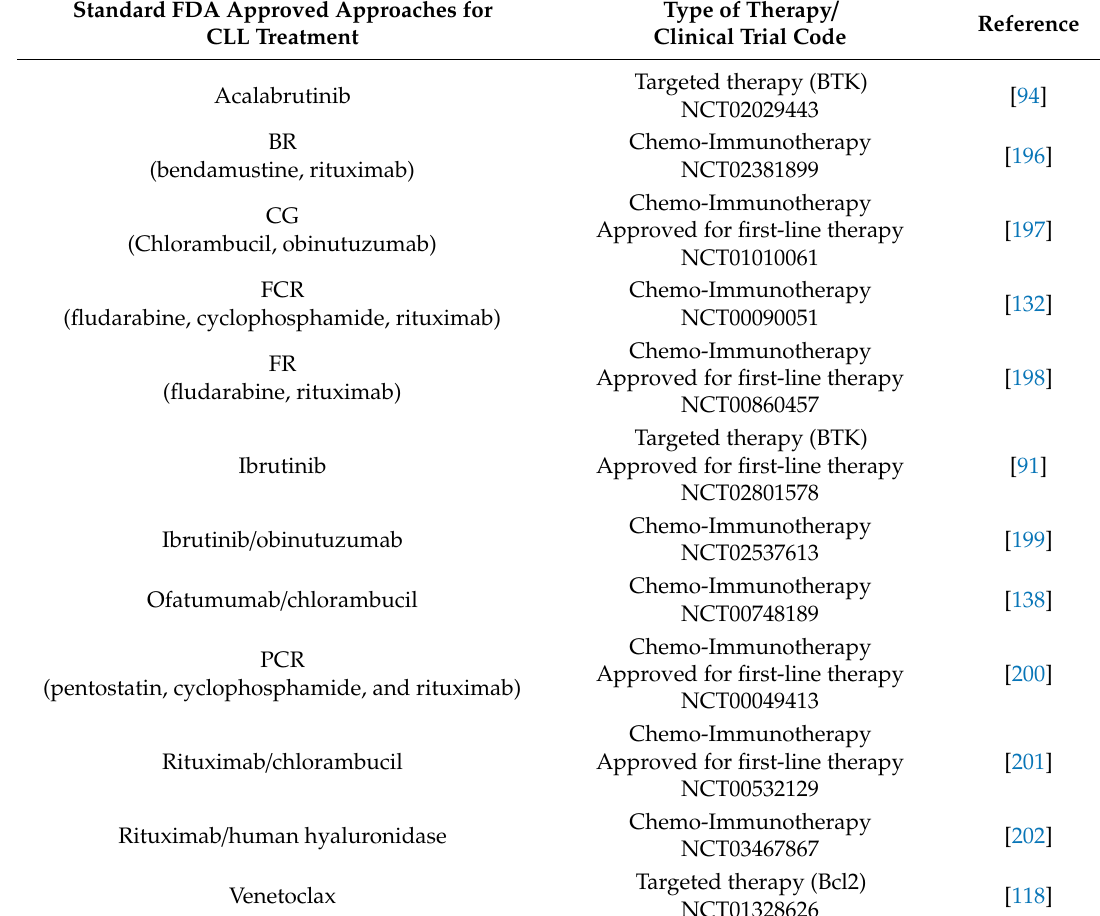
Table 1. Therapeutic approaches for CLL treatment (FDA approved and ongoing clinical trials). Standard FDA Approved Approaches